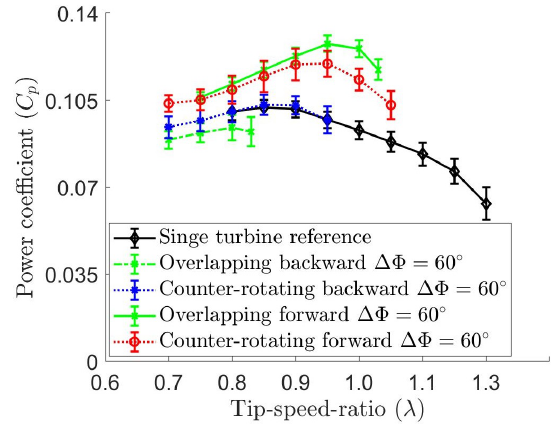
Figure 13. Power performance of the overlapping configurations compared to the single turbine reference C p curve and the counter-rotating configurations at ∆Φ = 60 ◦ .